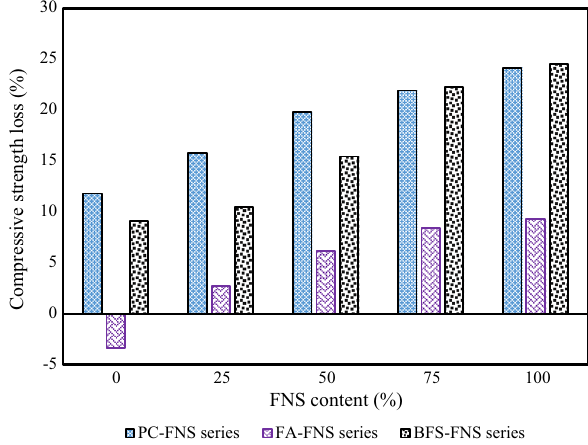
Fig. 6 ( a ) PC-FNS100 before wet–dry cycles and ( b ) PC- FNS100 after wet–dry cycles.